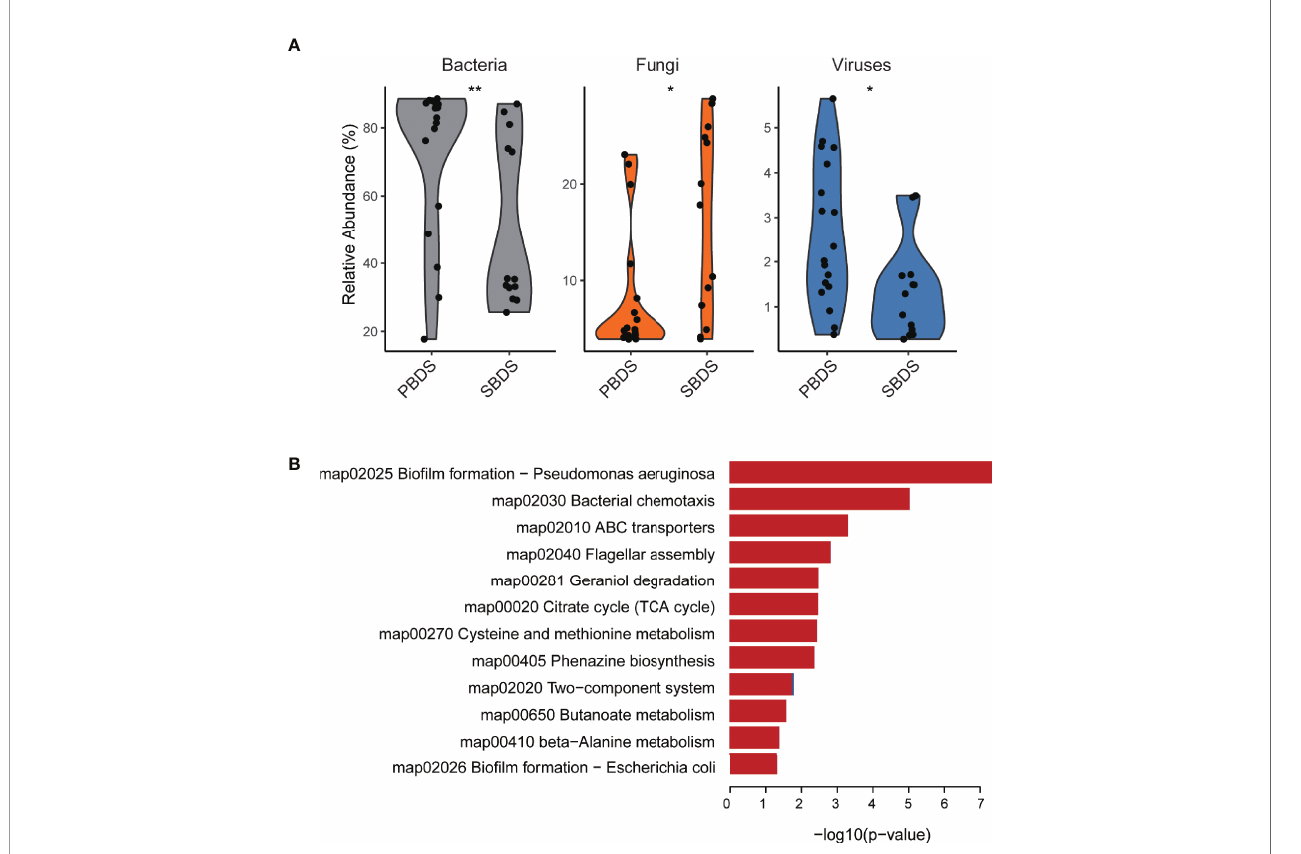
FIGURE 3 | Taxonomic and functional analysis of the wMGS data. (A) The percentage of bacteria, fungi, and viruses in each metagenomic sample among SBDS and PBDS (Wilcoxon test; *, FDR < 0.05; **, FDR < 0.01). (B) Different pathways between SBDS and PBDS, red represents orthologs up-regulated in the PBDS, and blue represents down-regulated. wMGS, whole metagenomic shotgun sequencing; PBDS, primary bile duct stone; SBDS, secondary bile duct